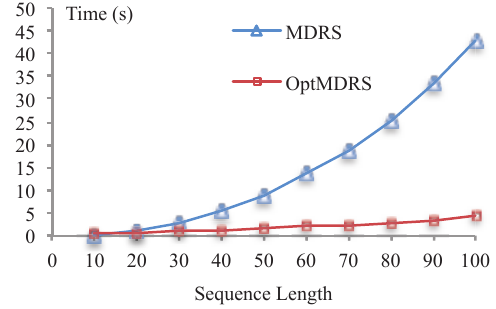
Fig. 5. Performance with increasing sequence